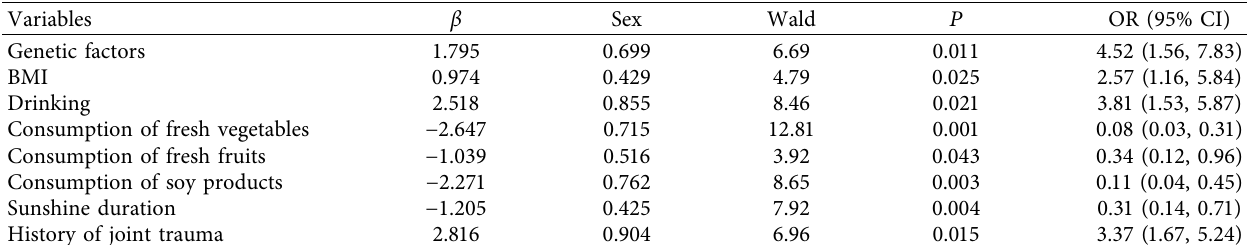
Table 3: Logistic regression analysis of multivariate conditions influencing factors of OA.